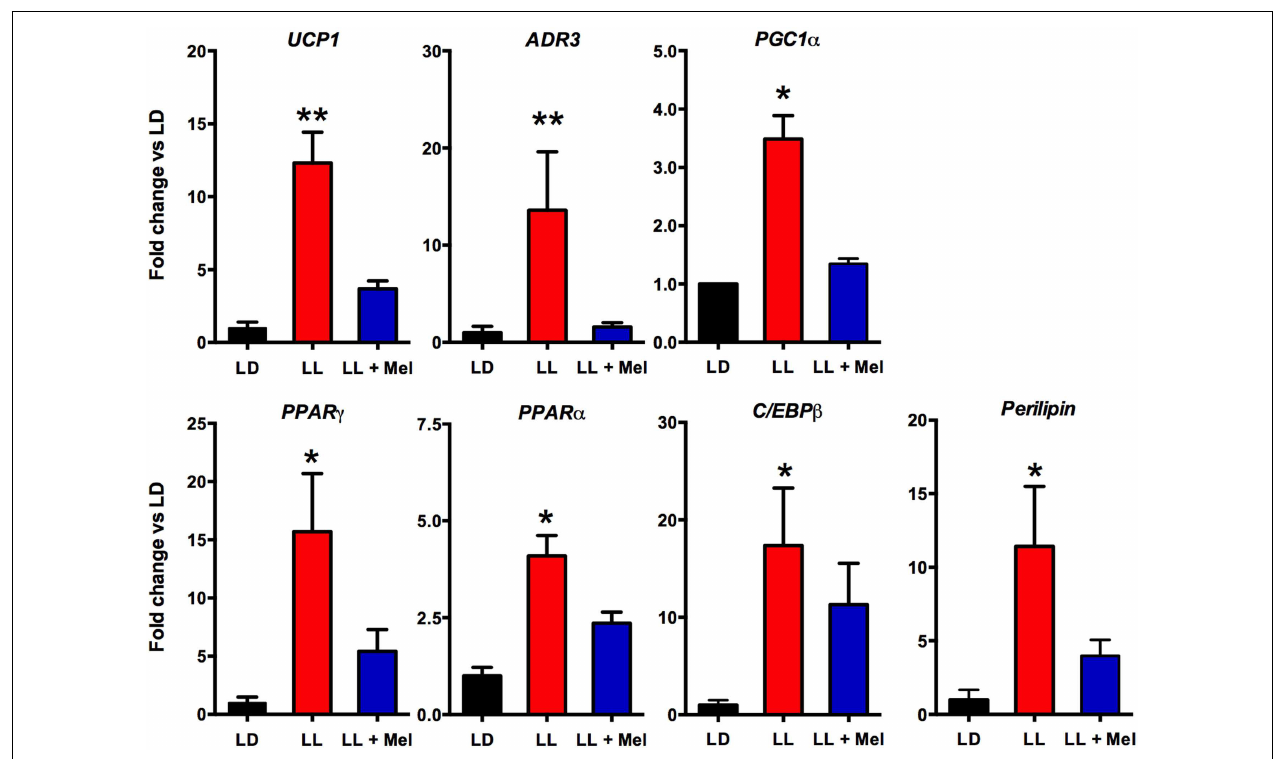
LL + Mel, newborns gestated in ewes kept in continuous light but receiving an oral dose of 12mg melatonin at 1700h. LD and LL n = 6. LL + Mel n = 4. * P < 0.05 vs. LD; ** P < 0.05 vs. LD; and LL + Mel, ANOVA, andTukey’s